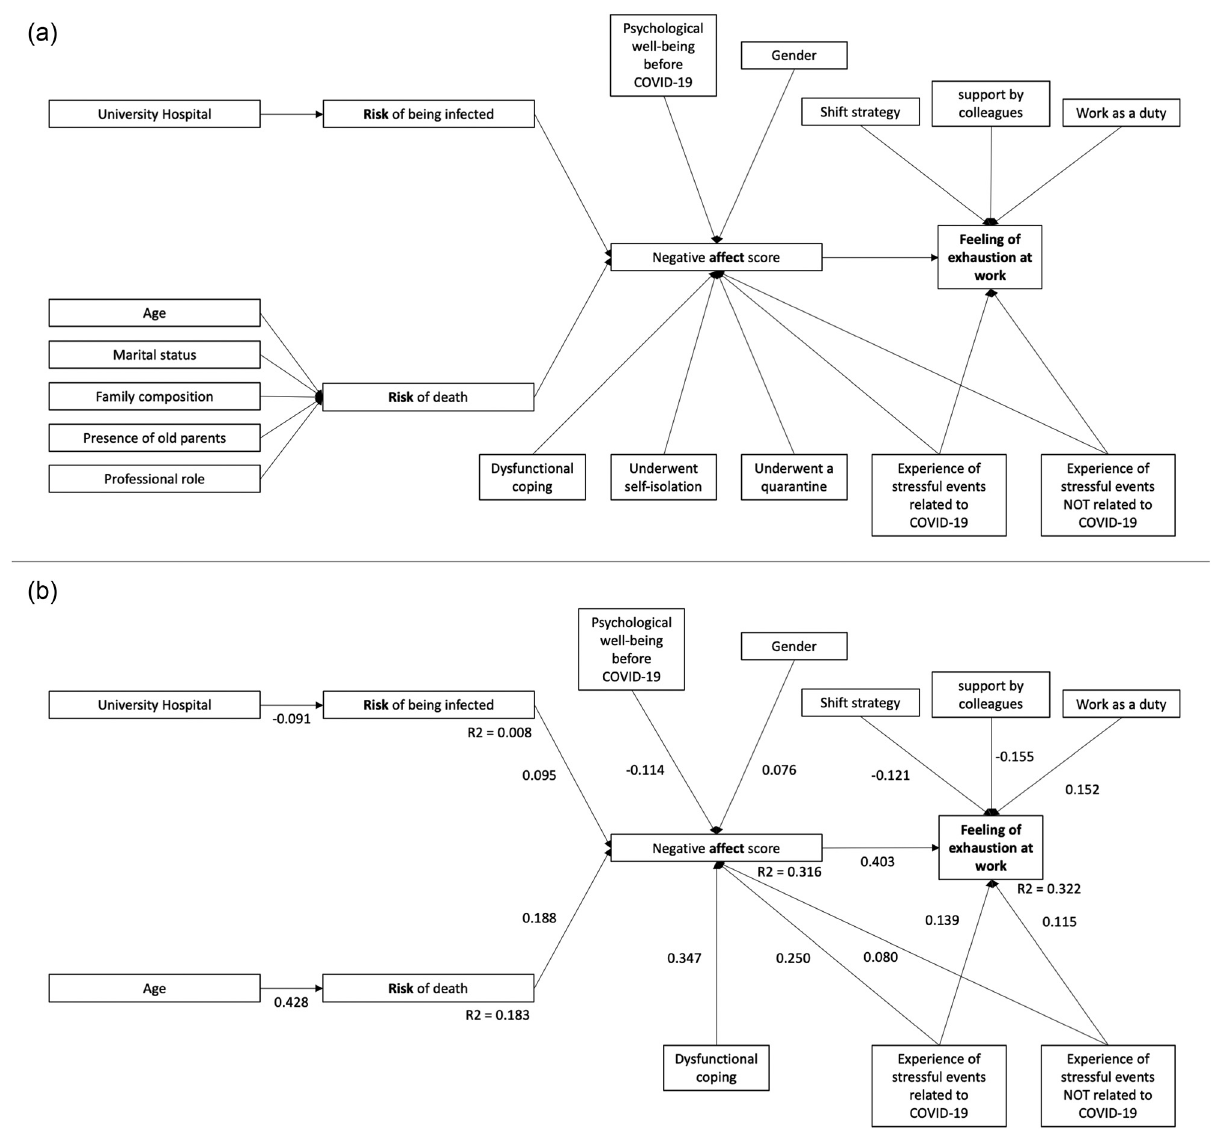
Figure 1: ( a ) Initial structural model based on the study hypothesis and the results of the multivariable generalized linear regression model predicting WE and observed univariate associations. ( b ) Final structural model and standardized path coe ffi